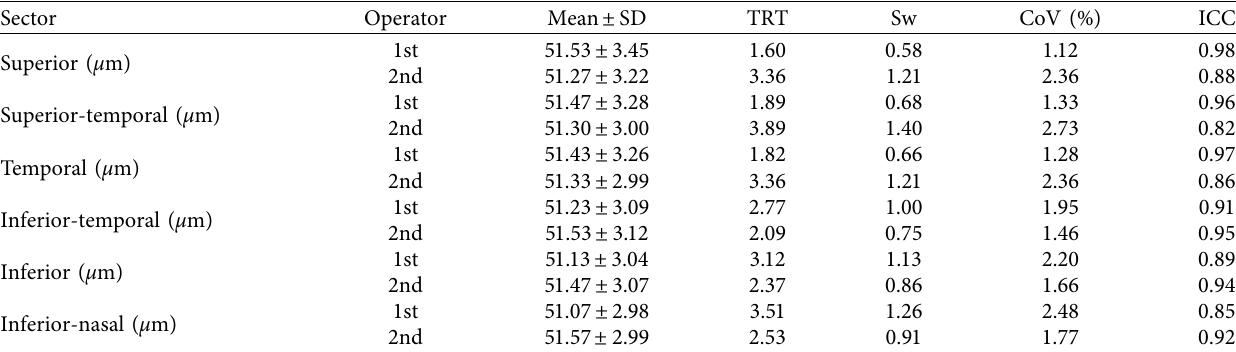
Figure 1: Topography maps and ETMs generated during a simultaneous measurement by REVO NX with 16 evenly spaced meridian B- scans of 8-mm width. To the right of each map are the color scales used to represent the analyzed parameter. Table 1: Intraobserver repeatability results for ETMs using REVO NX based on three measurements taken by 2 operators in a sample of 40